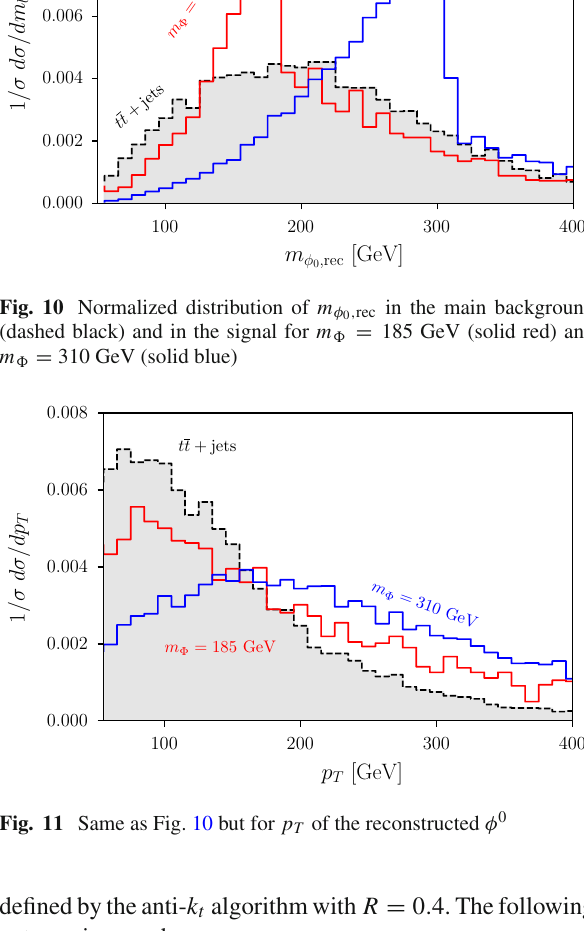
Fig. 11 Same as Fig. 10 but for p T of the reconstructed φ